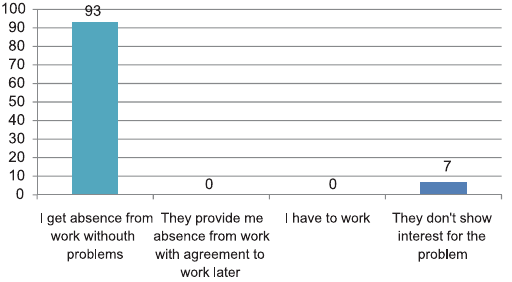
FIGURE 9. Understanding of the organizational unit’s manag- ers - supervisors for unpredicted situations of the employee (illness, family member illness, exams,